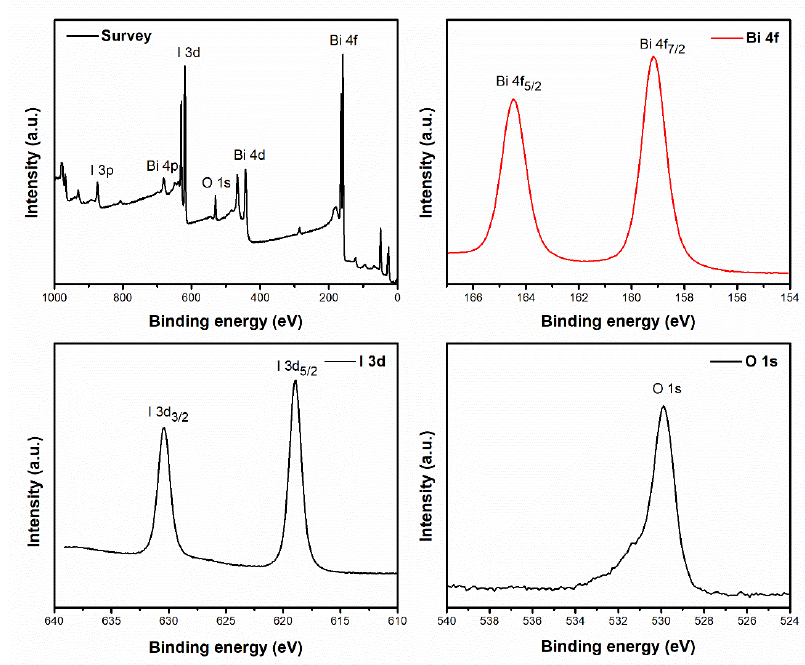
Figure 1. XPS spectra of BiOI photocatalyst.